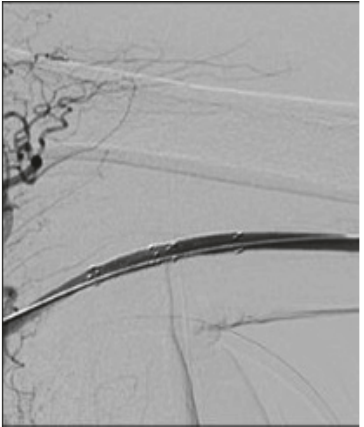
Figure 6: Repeat angiogram of the left brachial artery showed no residual stenosis after balloon angioplasty and